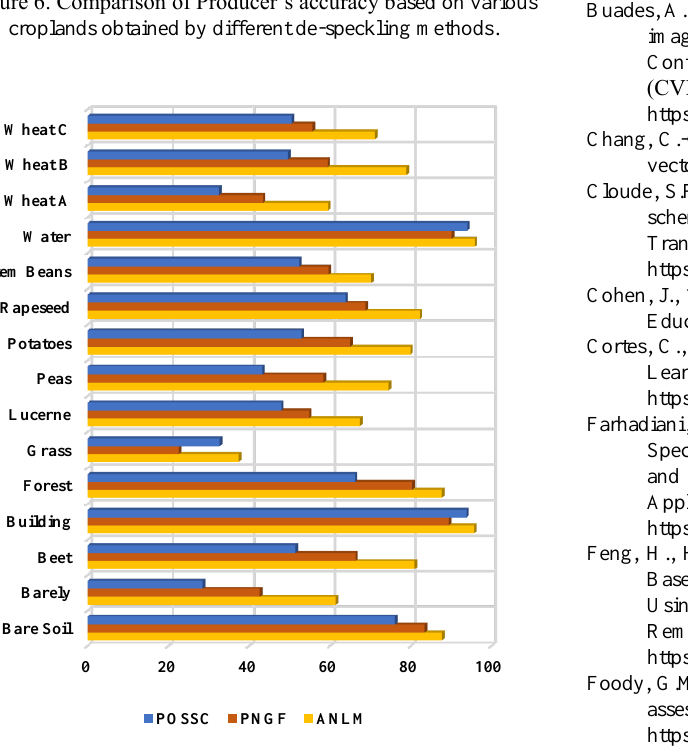
Figure 7. Comparison of User’s accuracy based on various croplands obtained by different de-speckling